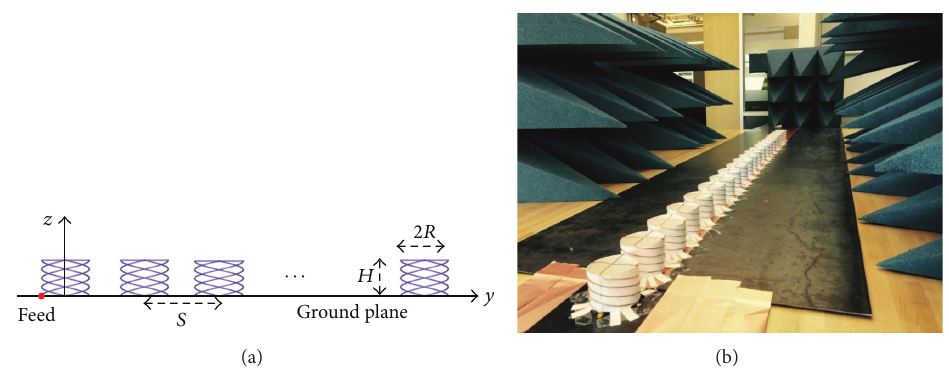
Figure 1: 1D folded cylindrical helix array setup: (a) simulation and (b) measurement.